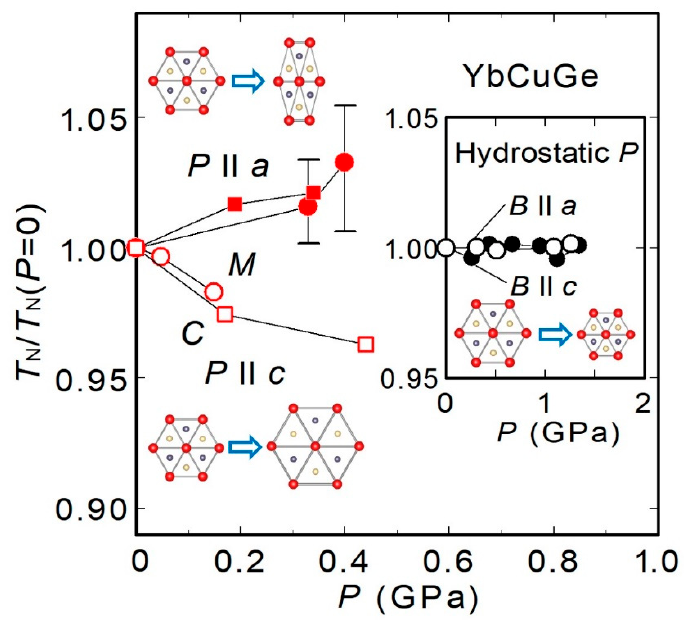
Figure 5. Uniaxial pressure dependence of the antiferromagnetic ordering temperature T N of YbCuGe, where the data of T N are normalized by the value at ambient pressure. The inset shows the hydrostatic pressure dependence of T N . The circles and squares denote the data obtained from the specific heat C and magnetization M measurements, respectively. The schematic changes in the triangular configuration in the hexagonal c plane under uniaxial and hydrostatic pressures are drawn in the main frame and inset, respectively. The balls in red, yellow, and black denote the Yb, Cu, and Ge atoms,